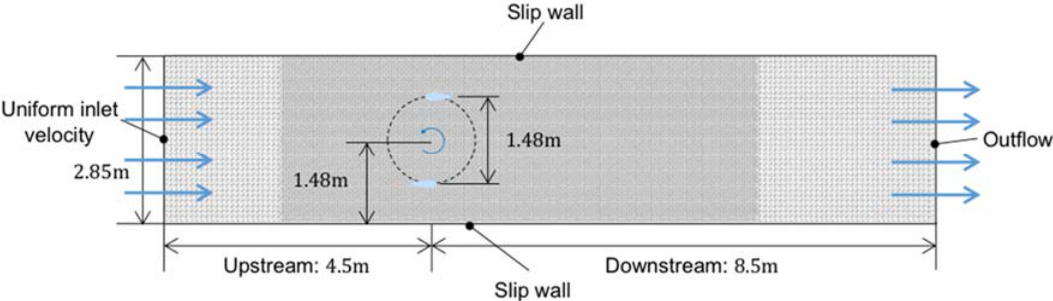
Figure 3. Computational mesh and boundary conditions, showing plan dimensions of the modelled domain.